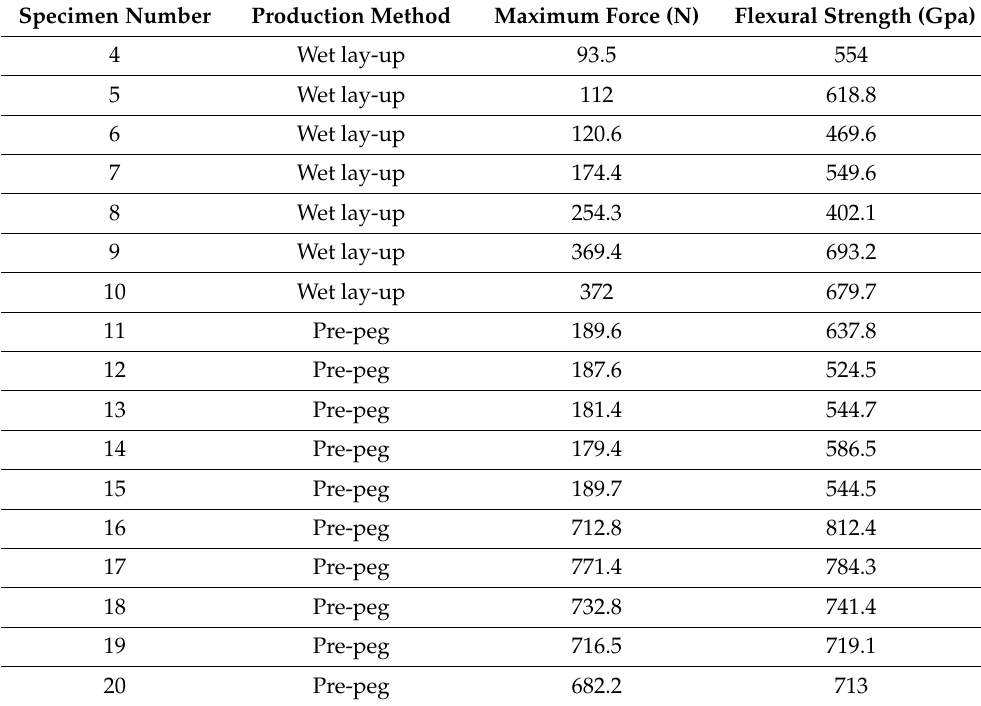
Table 2. CF specimen’s characteristics, production methods and calculated values of flexural strength.